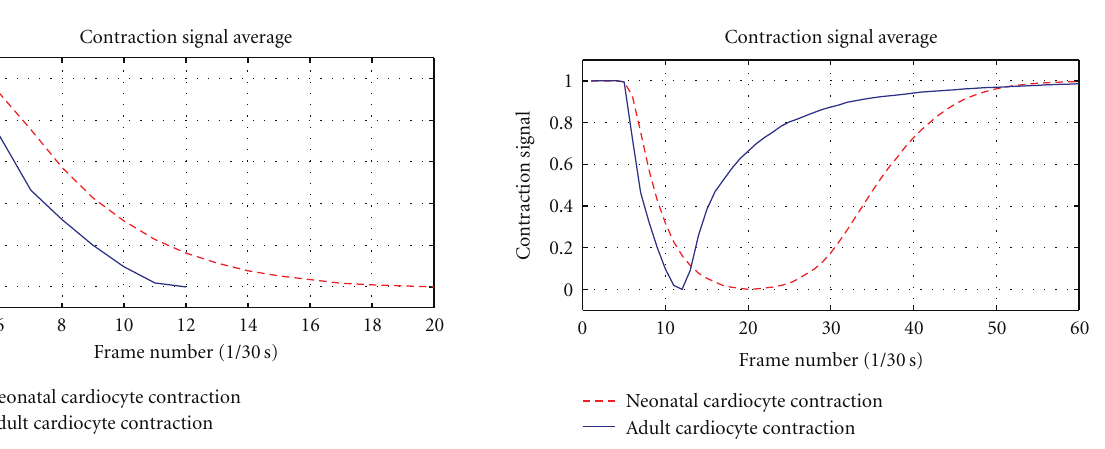
Figure 11: Solid line: Average adult cardiocyte contraction phase measured using image processing based techniques recently pro- posed in [17]. Dashed line: Average neonatal cardiocyte contraction phase measured using the proposed methodology. Results are in accordance with the expected outcomes given the marked di ff er- ences in the development of both cell types and their di ff erence in Ca 2+